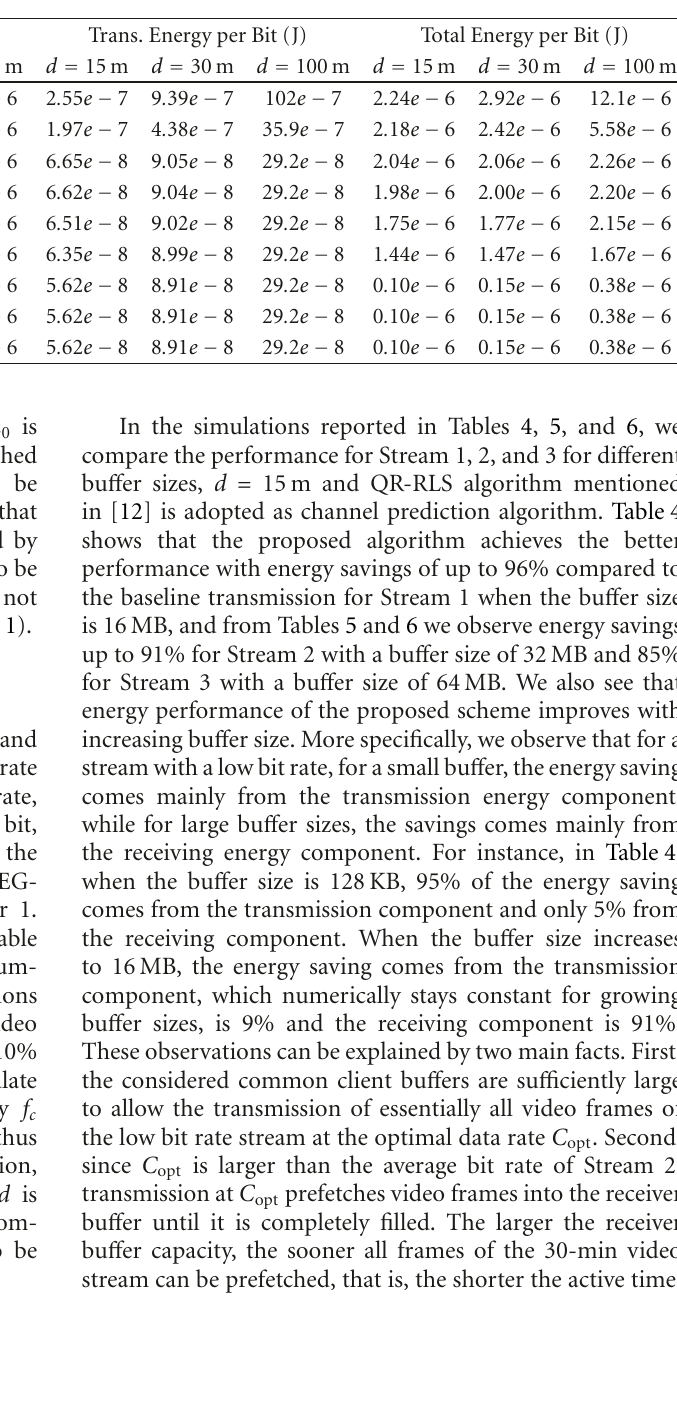
Table 7: Performance comparison for di ff erent distances for Stream